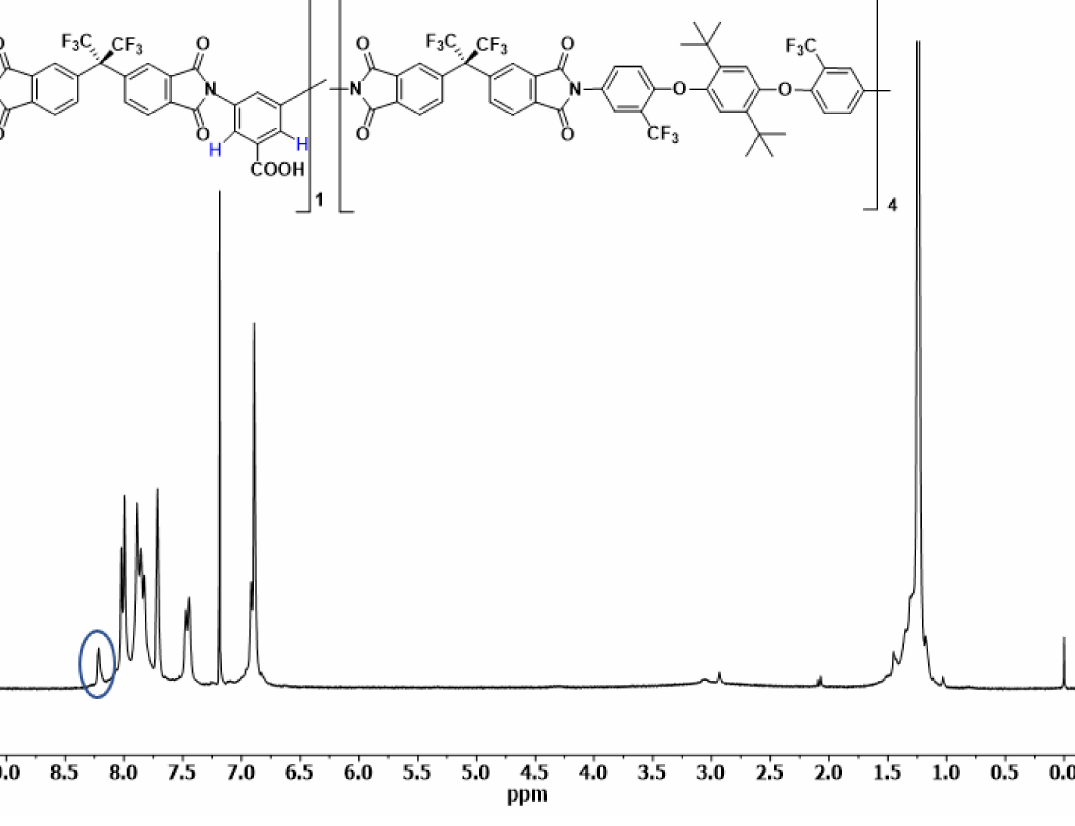
Figure 5. 1 H-NMR spectrum of COPOL-DABA(1/4).